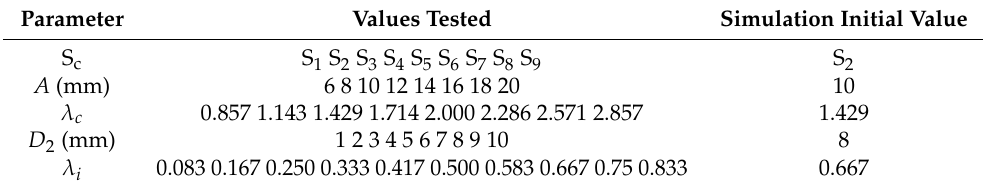
Table 3. Test parameters and values.